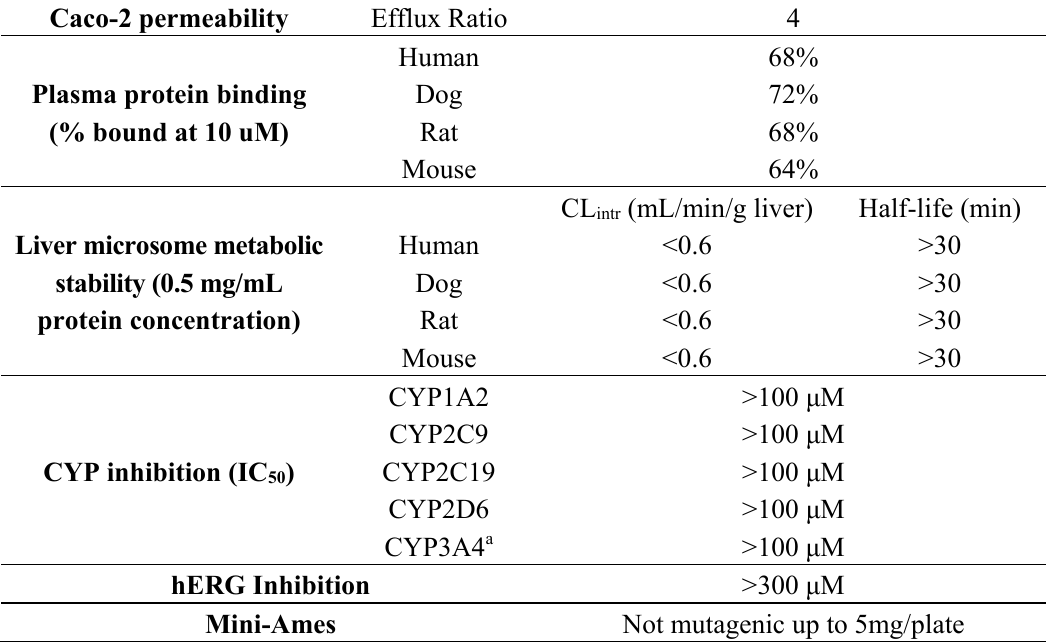
Table 2. In vitro ADME properties of